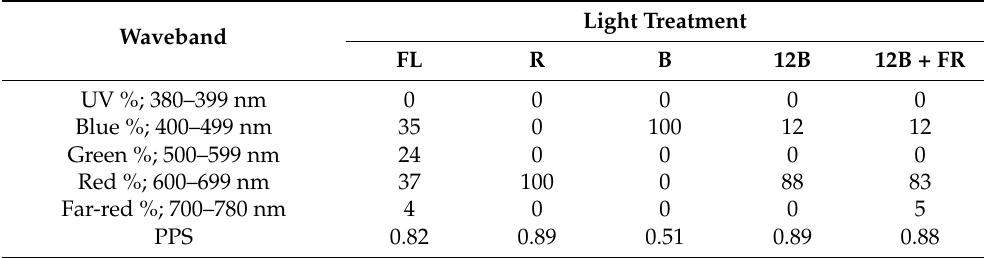
Table 1. Wavelength distribution and photobiological parameters of the tested light treatments tested. PPS: phytochrome photostationary state. PPS was calculated according to Sager et al. [9]. Light Treatment Waveband FL R B